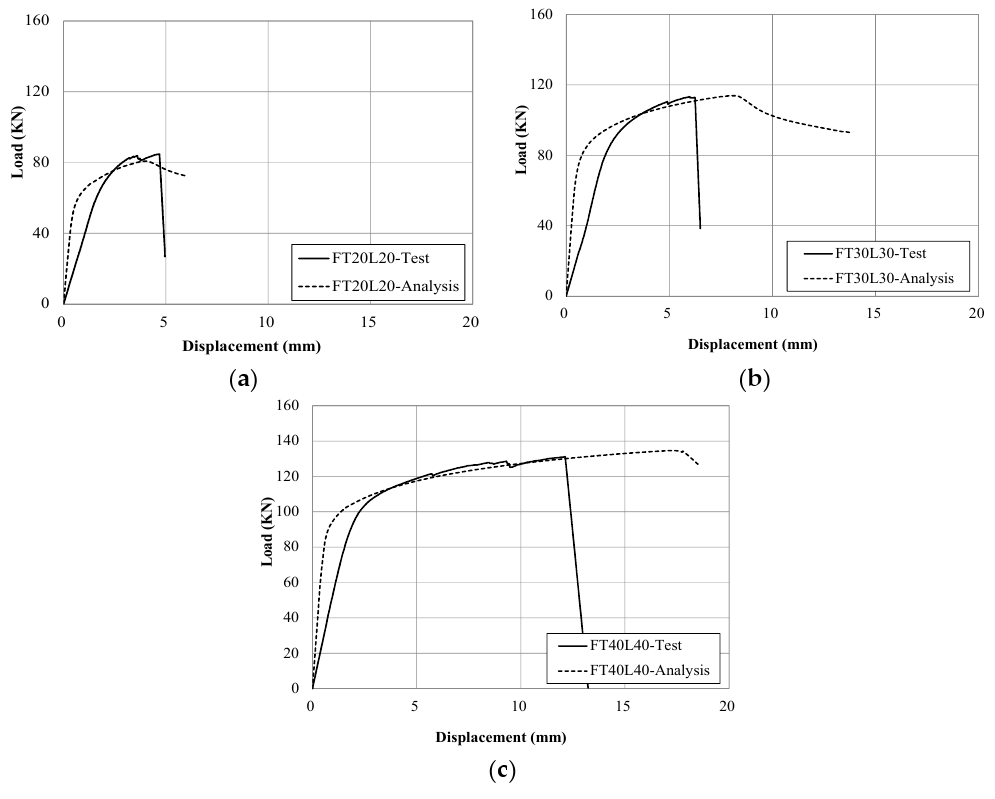
Figure 4. Comparison of load-displacement curves obtained from test and analysis results: ( a ) FT20L20, ( b ) FT30L30, ( c ) FT40L40.